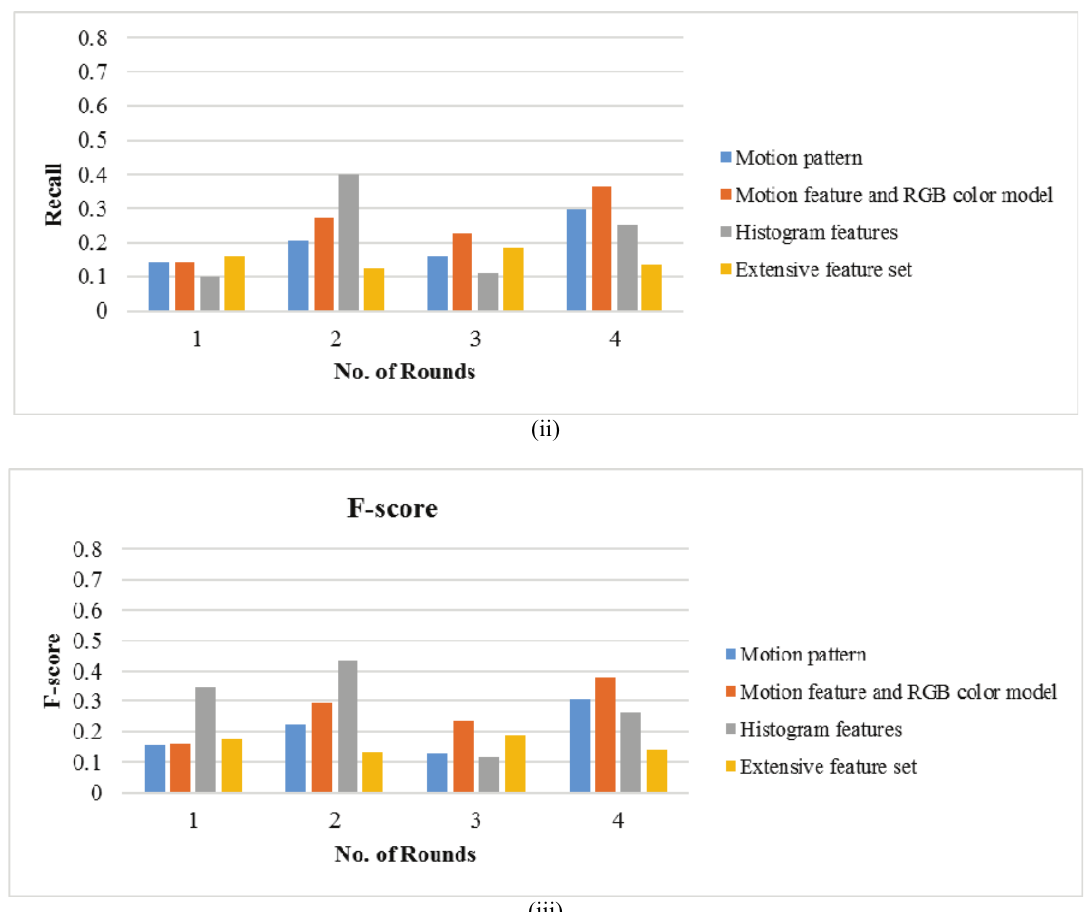
Fig.9. Comparison plot of Mean of Cartoon video data set (i) Precision, (ii) recall and (iii) F-score values for different rounds of retrieval obtained by the proposed CBVR system and other existing